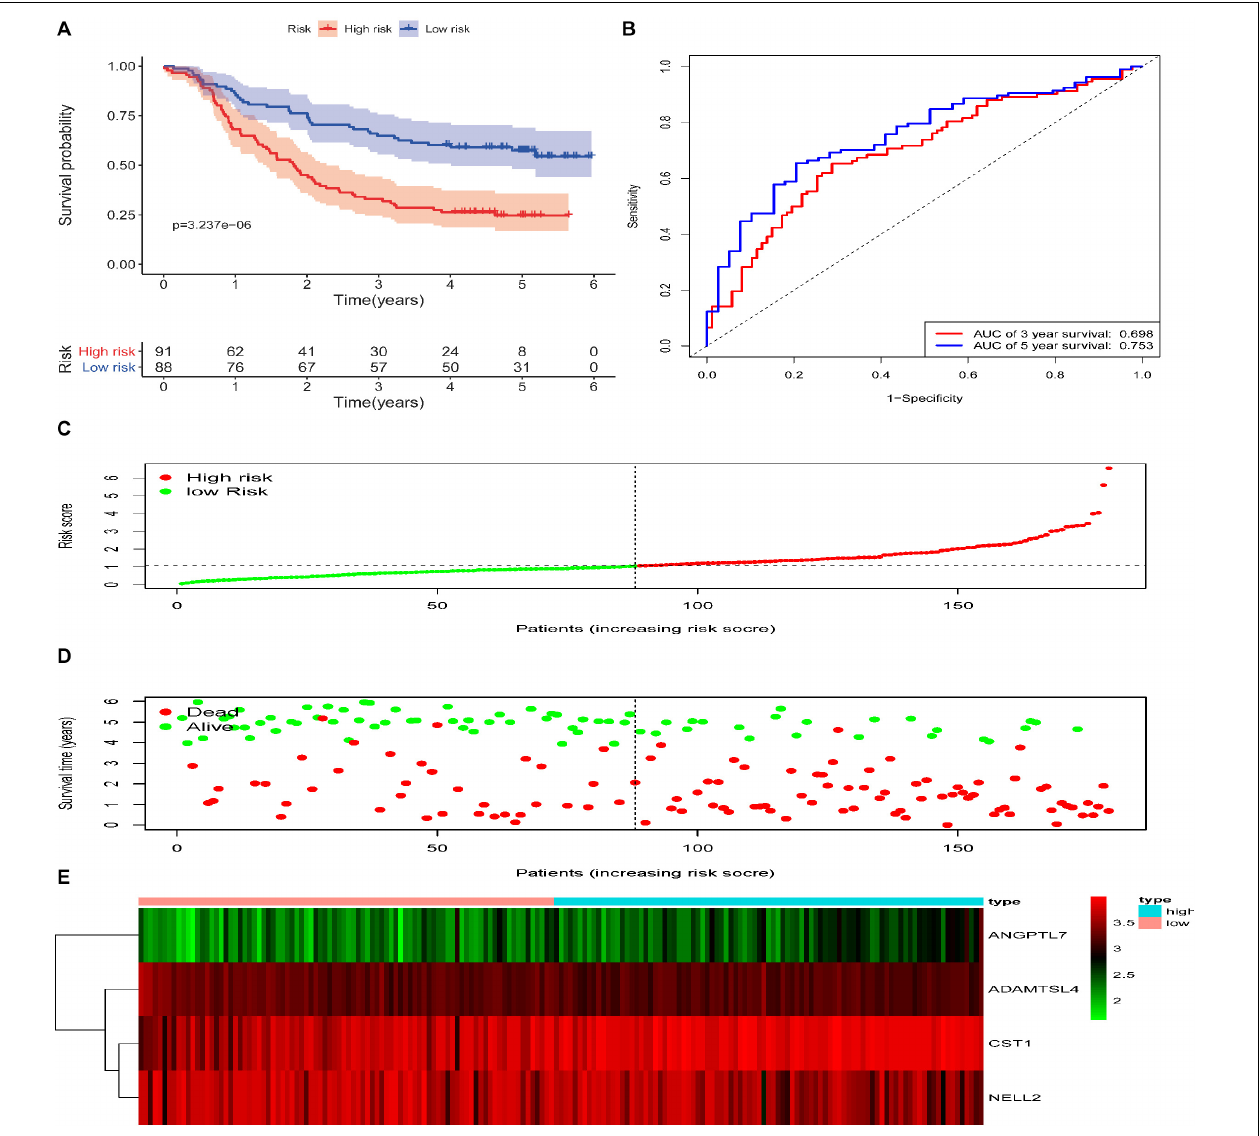
FIGURE 5 | Validation of the ECM–related signature in the entire cohort of patients with ESCC. (A) Kaplan-Meier survival curves of the relative overall survival of high- and low-risk patients. (B) ROC curve analysis of the prognostic signature. (C) Distribution of the four gene-based risk scores. (D) Vital statuses of patients in the high- and low-risk groups. (E) Heatmap of four-gene expression profiles in the high- and low-risk